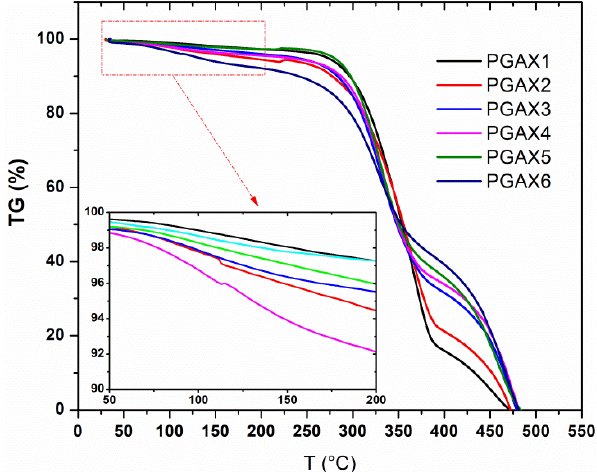
Figure 8. TGA analyses of PGAX blends under N 2 atmosphere.